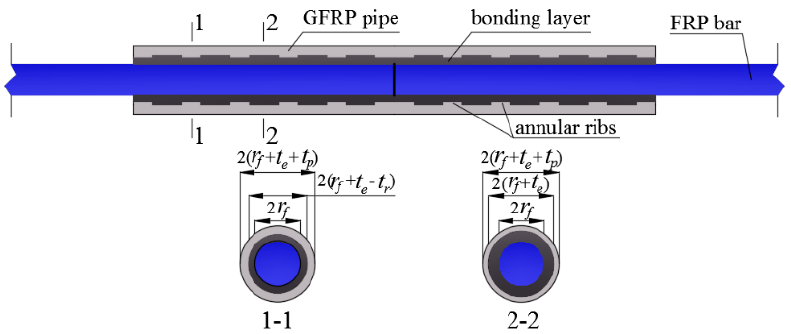
Figure 1. Proposed resin-filled GFRP pipe connection system for the butt splicing of FRP bars.